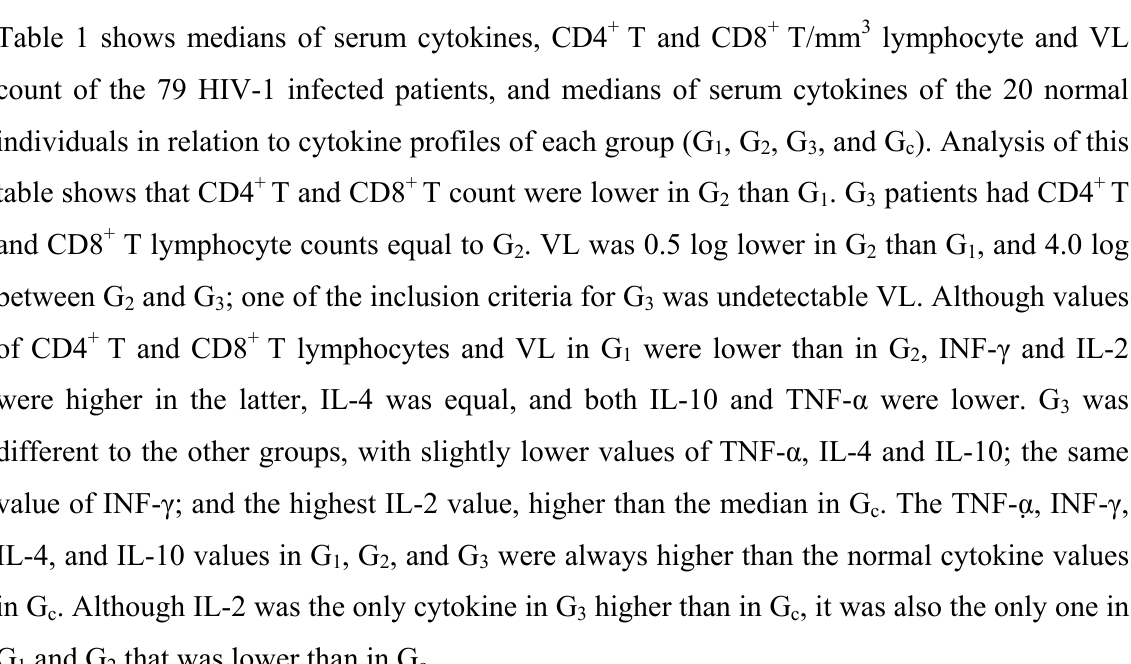
D. A. Meira et al . CORRELATION BETWEEN CYTOKINE SERUM LEVELS, NUMBER OF CD4 + T CELLS/mm³ AND VIRAL LOAD IN HIV-1 INFECTED INDIVIDUALS WITH OR WITHOUT ANTIRETROVIRAL THERAPY.